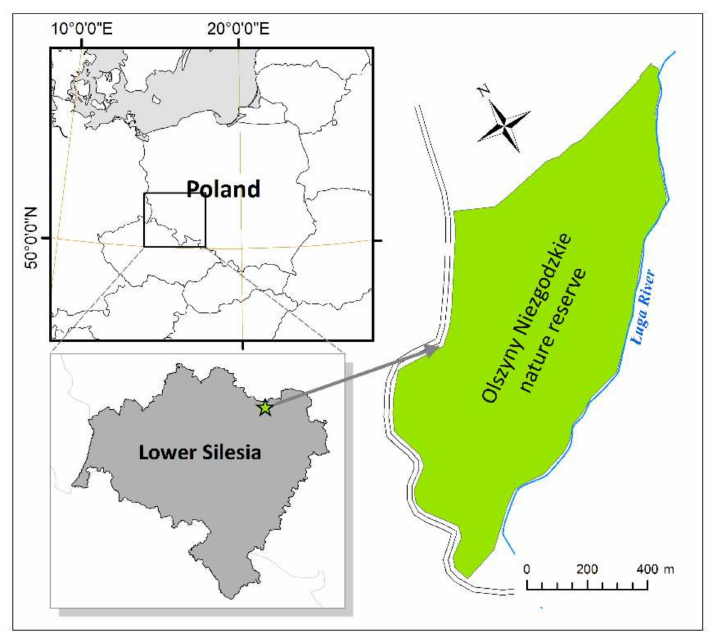
Figure 1. Location of the Olszyny Niezgodzkie nature reserve in the Central-European and regional (Lower Silesia)